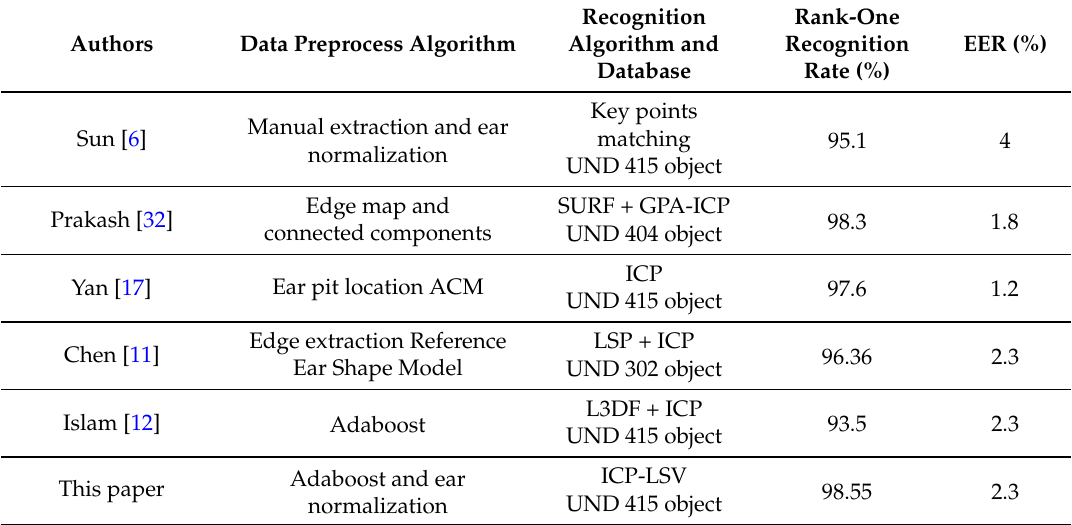
Table 5. A comparison of the proposed approach with similar approaches 1 .